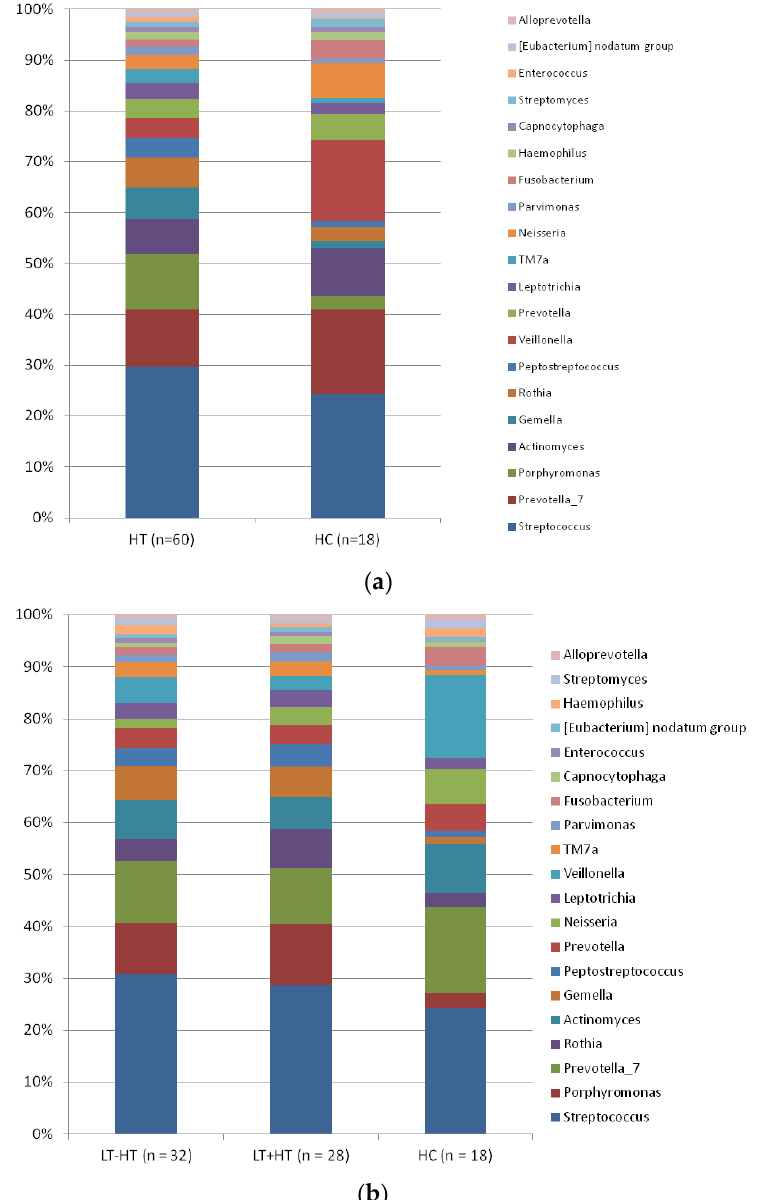
Figure 4. ( a ) The distributions of the predominant bacteria at the genus level between HT and HC groups. (HT: Hashimoto’s thyroiditis. HC: Healthy control). ( b ) The distributions of the predominant bacteria at the genus level between LT-HT, LT + HT, and HC groups. (HT: Hashimoto’s thyroiditis. LT + HT: Euthyroid HT treated with levothyroxine (L-T4). LT-HT: euthyroid HT without L-T4 therapy. HC: Healthy control).